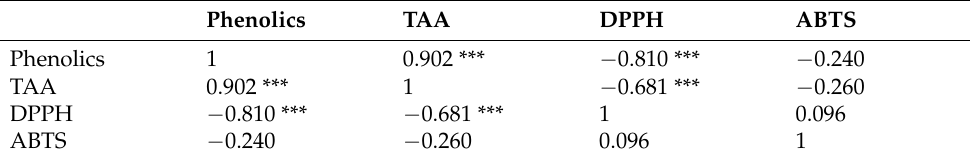
Table 5. Pearson coefficients between phenolics, TAA, DPPH, and ABTS.